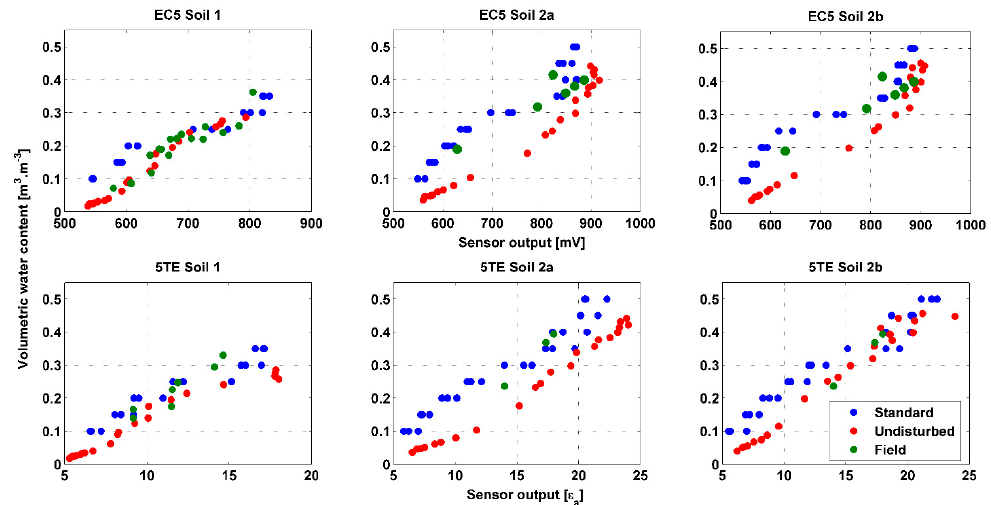
Figure 7. Sensors outputs plotted against the volumetric water content, obtained on the basis of direct calibration methods.